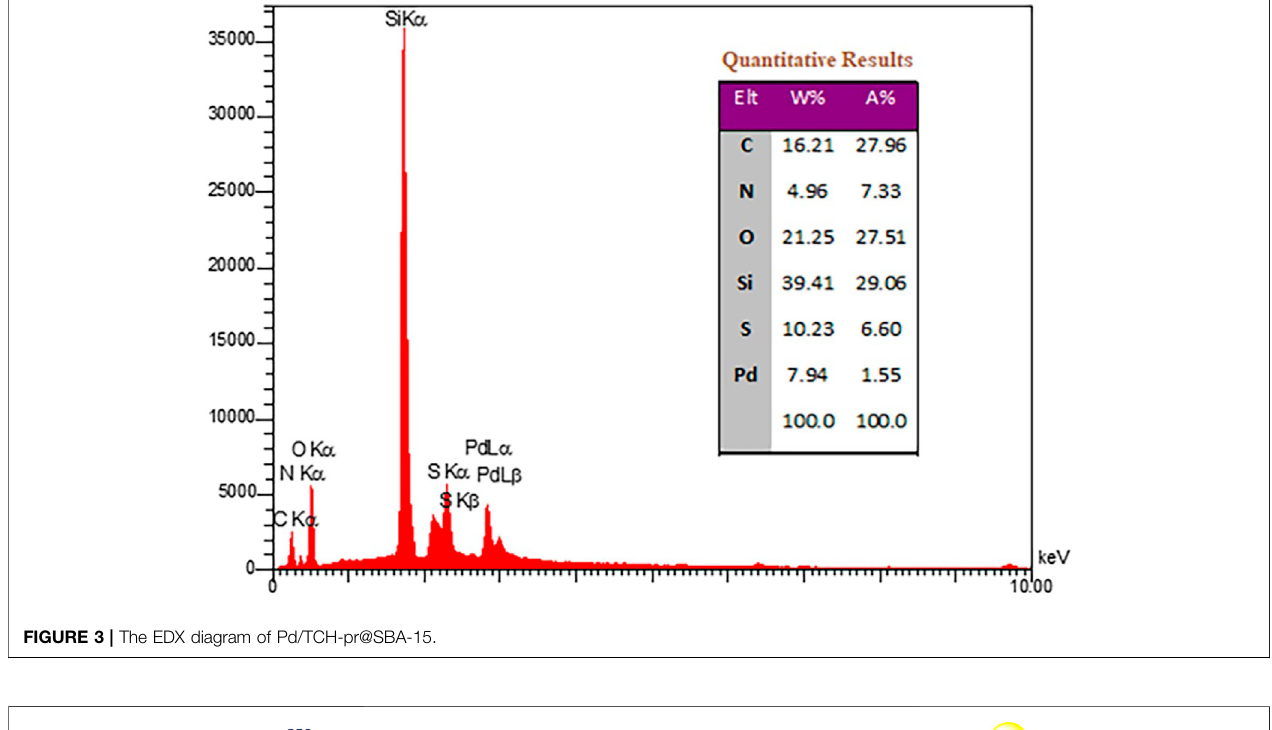
FIGURE 3 | The EDX diagram of Pd/TCH-pr@SBA-15.